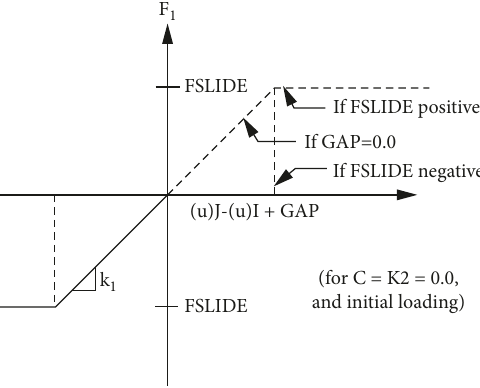
Figure 9: Volume and shell model of the braced column.